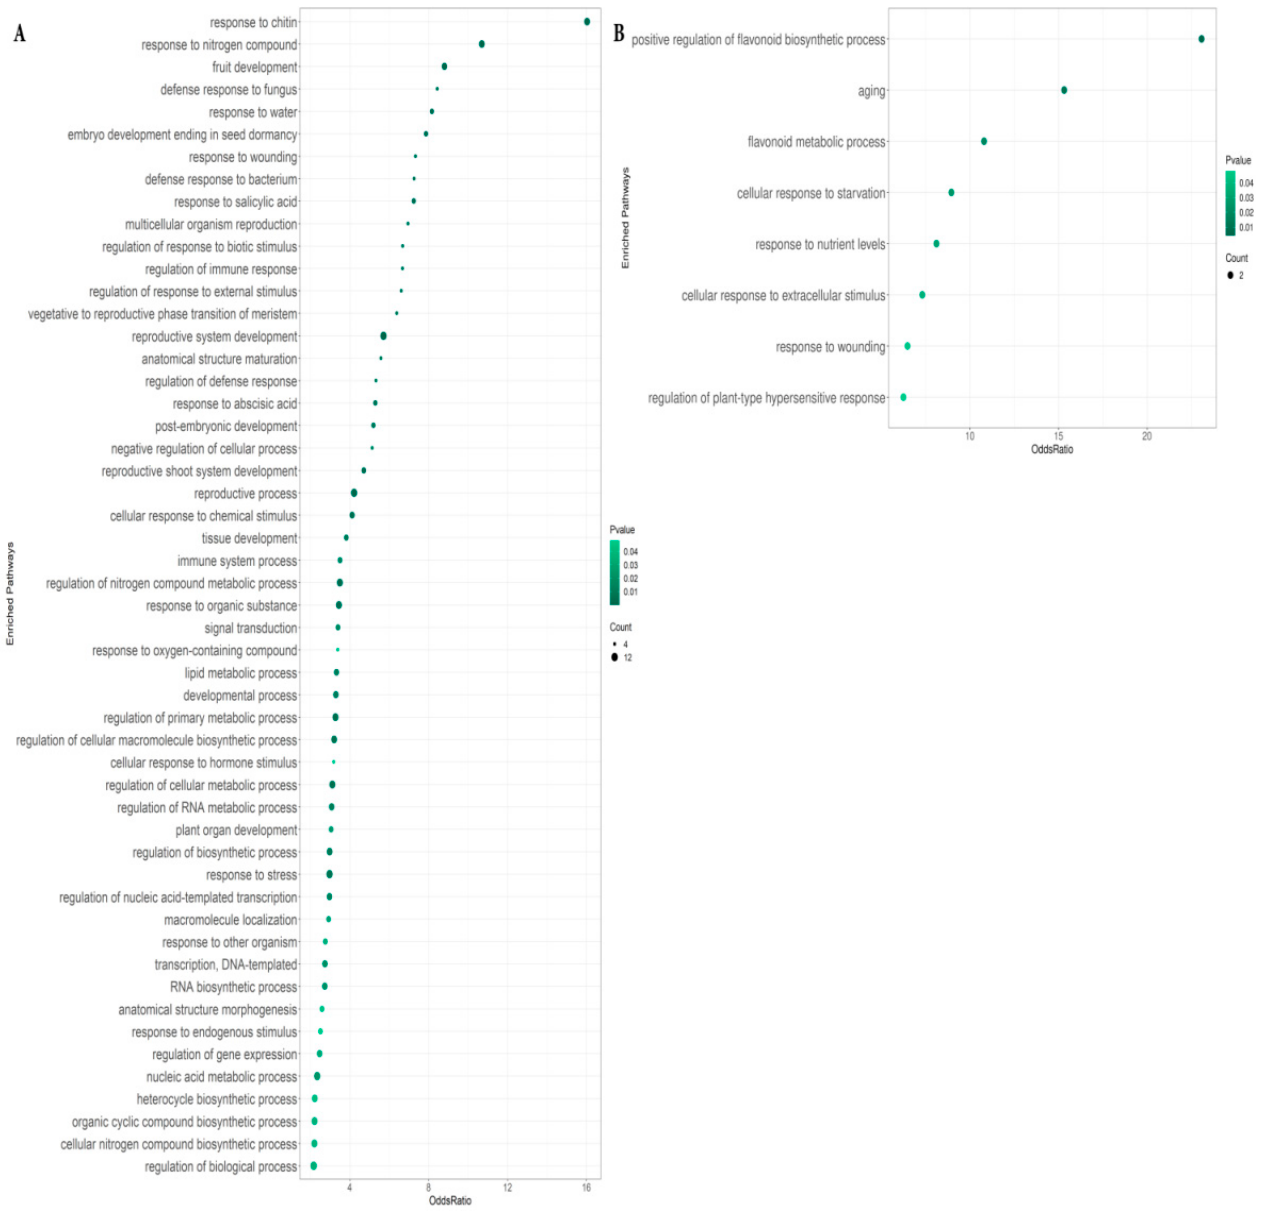
Figure 2. Overrepresented “biological process” GO pathways in genes upregulated ( A ) and downregulated ( B ) in the 35S:RsCLE41-1 roots in comparison to 35S:GUS roots of radish. Count is the number of DEGs included in the respective pathway.